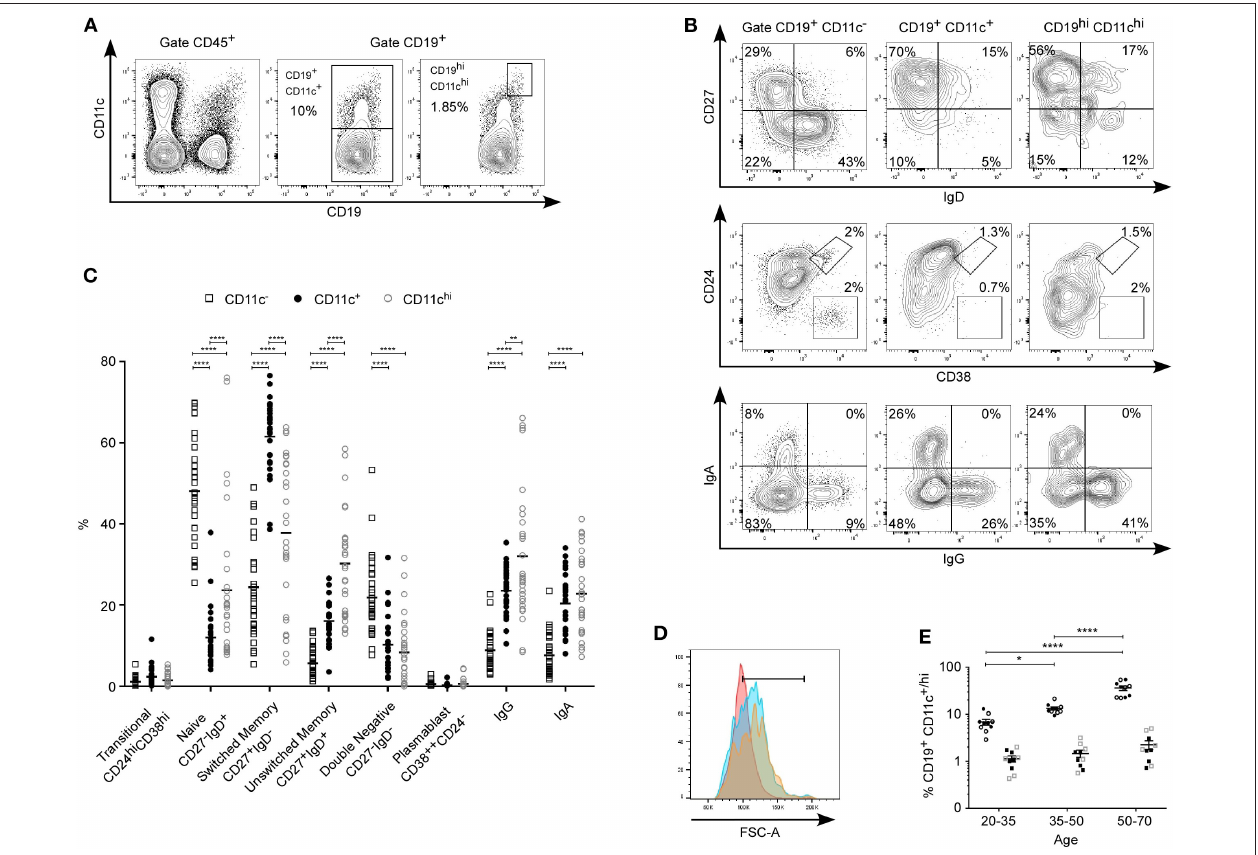
FIGURE 1 | Phenotyping of human CD11c + B cells. (A) Expression level of CD11c and CD19 and gating strategy to study CD19 + CD11c − , CD19 + CD11c + , or CD19 + CD11c hi with one representative frequency. (B) CD27, IgD, CD24, CD38, IgA, and IgG expression on CD19 + CD11c − , CD19 + CD11c + , or CD19 + CD11c hi with one representative frequency, and (C) proportion of transitional B cells, naive, switched memory, unswitched memory, double negative, plasmablast, IgG + , and IgA + for n = 30 healthy donors. (D) Forward scatter histogram overlay for CD19 + CD11c − (pink), CD11c + (blue), and CD11c hi (yellow). The gate is used to determine the Geo mean fluorescence intensity, which is 0.98, 10.8, and 11.3 × 10 4 , respectively. (E) Percentage of CD11c + and CD11c hi B cells for donors between age 20 and 35, 35 and 50, and 50 and 70 years old ( n = 10 for each group; circle = CD11c + B cells, square = CD11c hi B cells, open symbol = woman, fill symbol = man). Significant difference is determined by two-way ANOVA with correction by Sidak’s multiple comparison test in (C) and with correction by Tukey’s multiple comparison test in (E) . * p < 0.05, ** p < 0.01, **** p < 0.0001. Dot plots from (A,B) , and histogram from (D) were obtained from a donor age